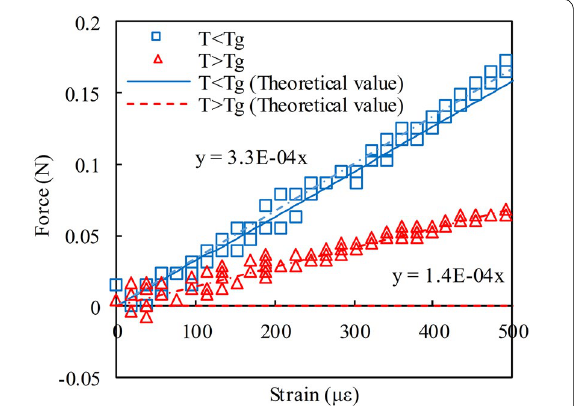
Fig. 5 Relationship between applied force and strain on SMP sheet (first prototype). The alternate long and short dash lines show linear approximation. The linear approximation formulae are also shown